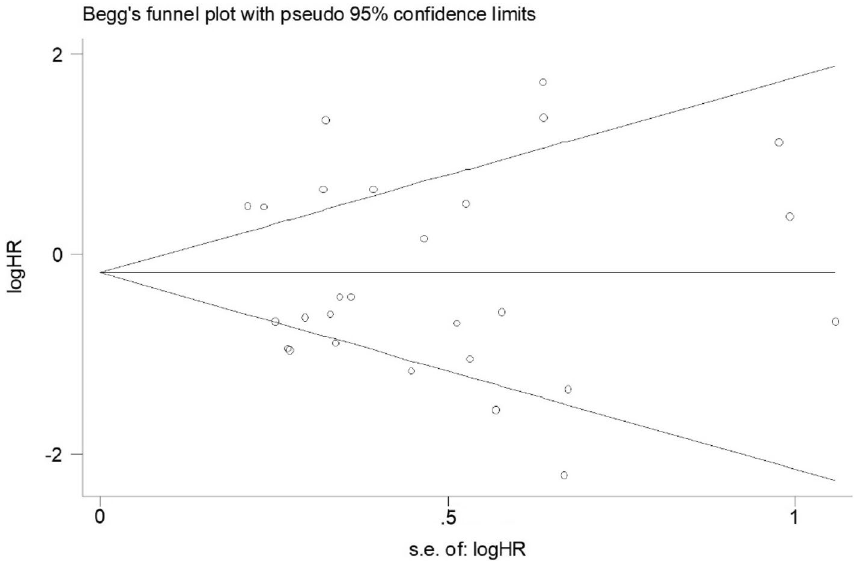
Figure 5. Begg’s funnel plots of publication bias for OS in all eligible studies. Each circle represents a separate study. OS overall